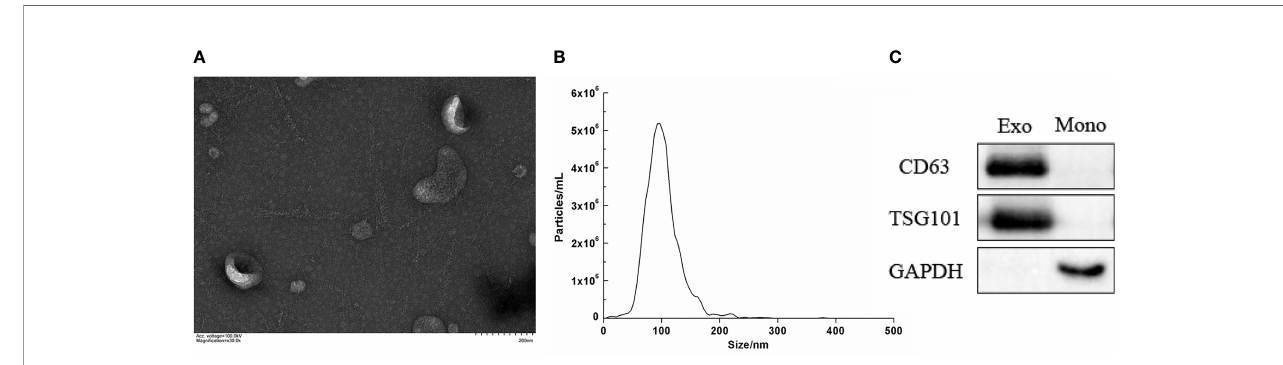
FIGURE 1 | Characterization of the isolated serum exosomes. (A) Morphology of serum exosome by electron transmission microscope (×30.0k). (B) Concentration and size distribution of serum exocrine. (C) The expression of the surface-speci fi c protein of exosome by Western blot. (Exo, exosomes; Mono, mononuclear cell; CD63 and TSG101 were